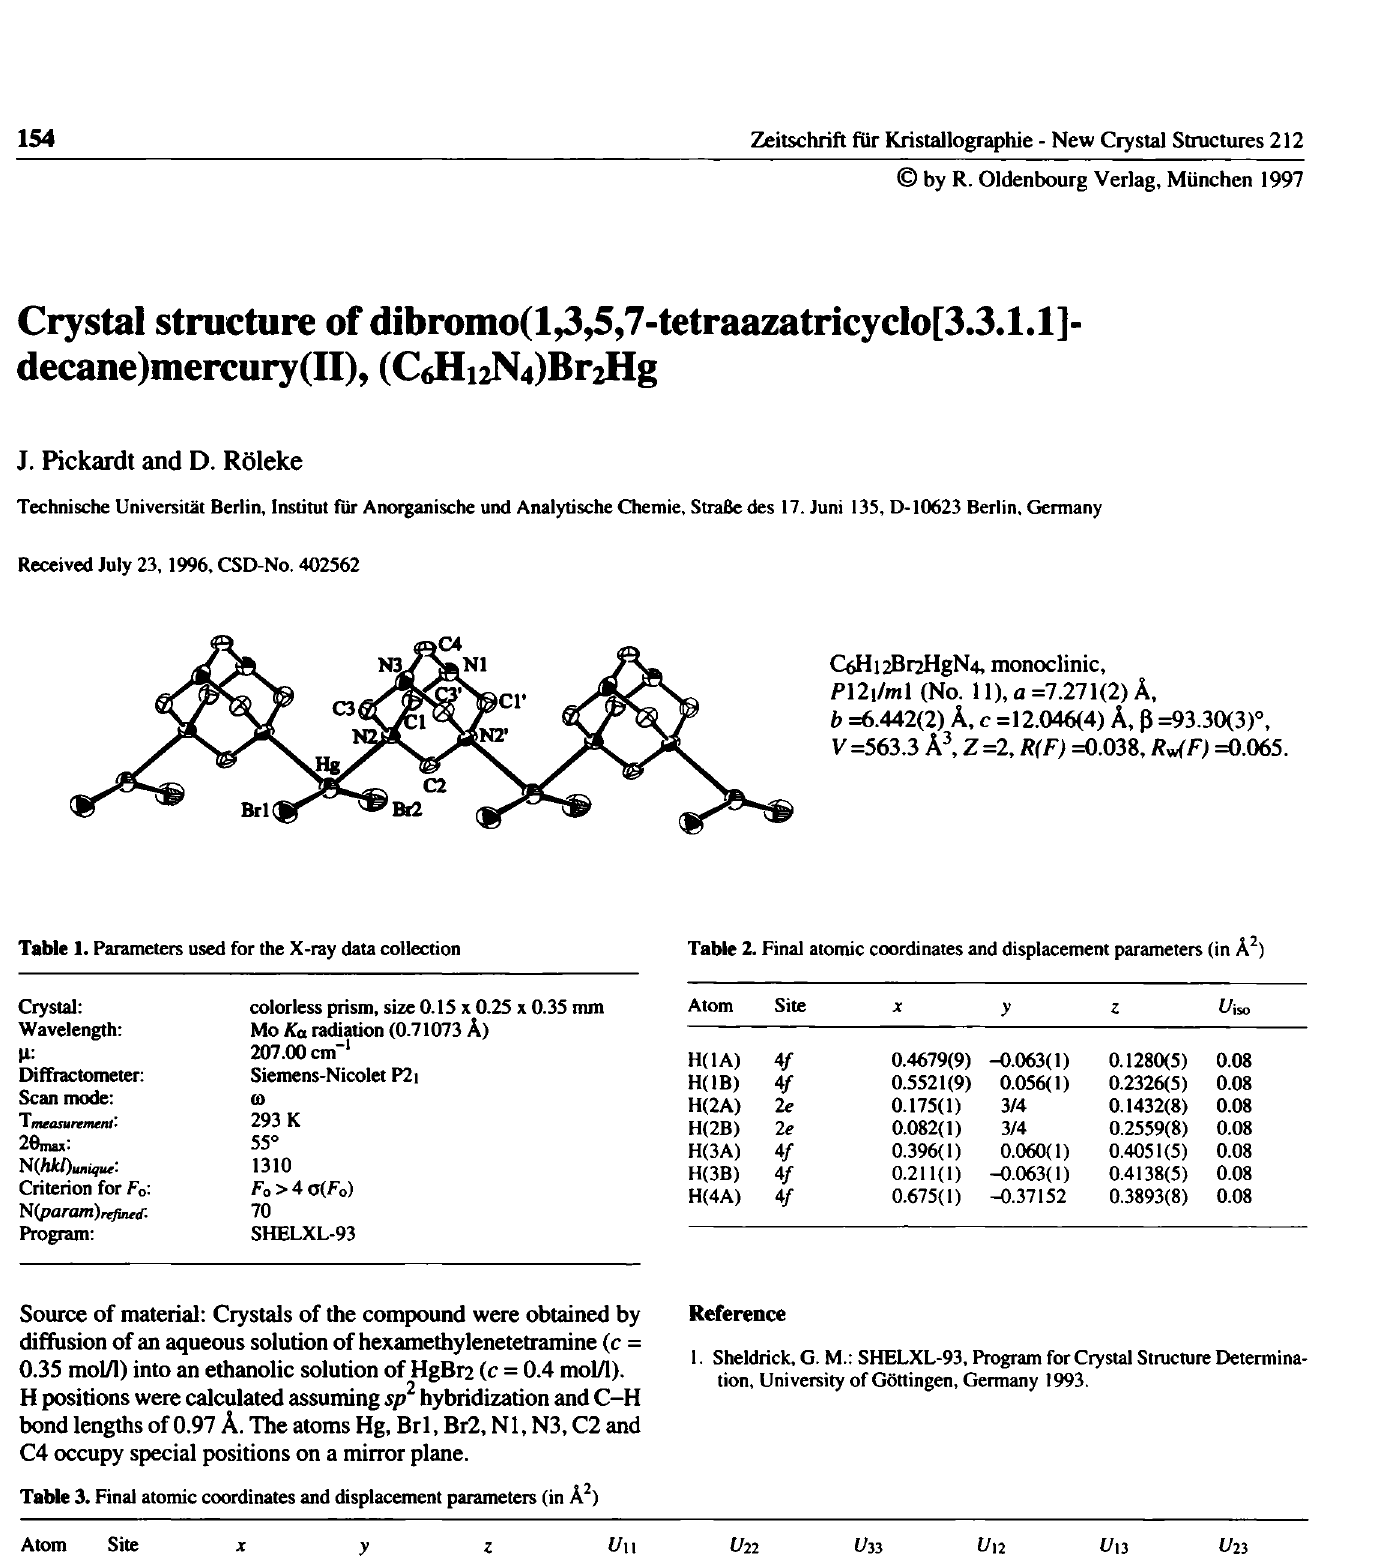
Table 3. Final atomic coordinates and displacement parameters (in Â 2 )